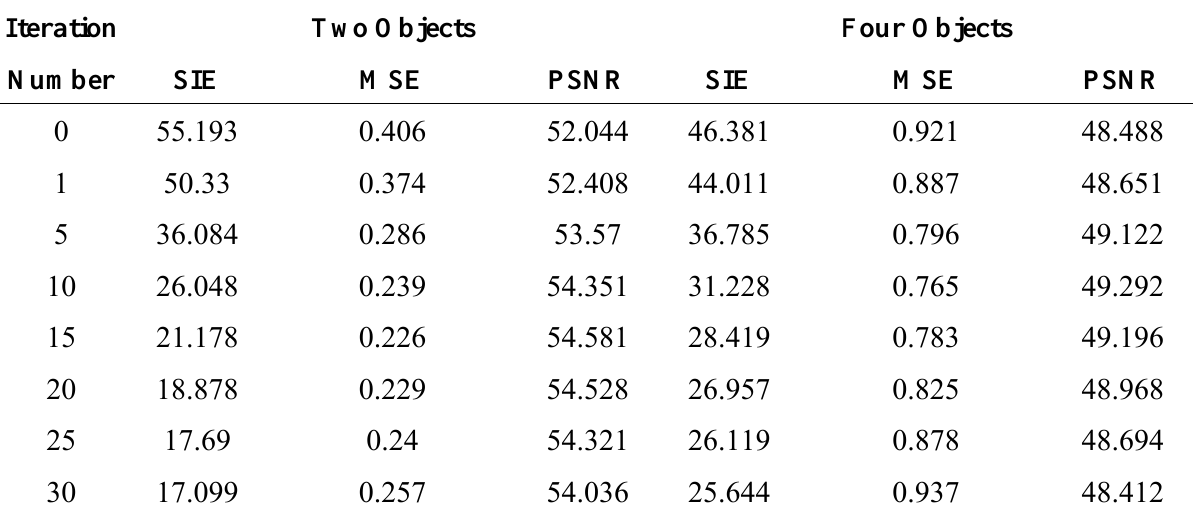
Table 1. Assessment of reconstructed images for two and four objects flow